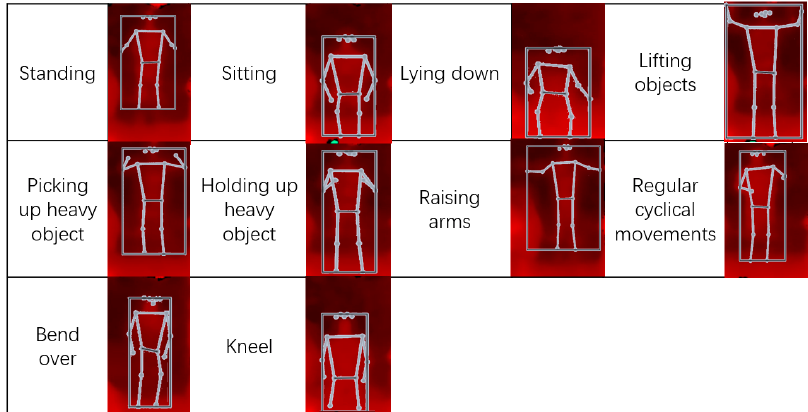
Figure 13. Example group of optimized depth motion capture for situation